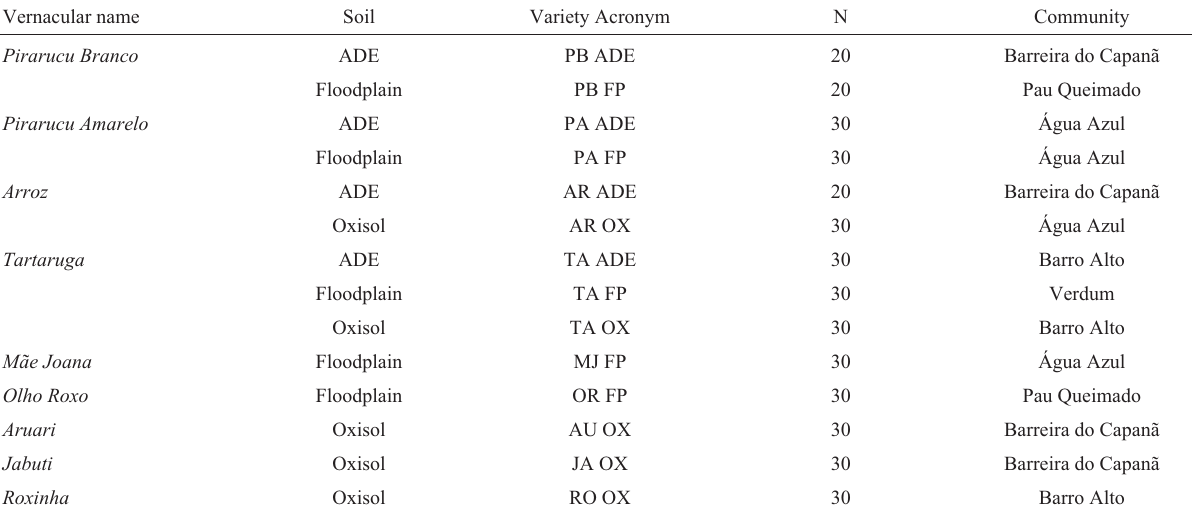
Table 1 - Manioc varieties sampled in different soils of different communities of smallholder farmers in the municipality of Manicoré, along the middle Madeira River, Amazonas, Brazil. N = number of individuals